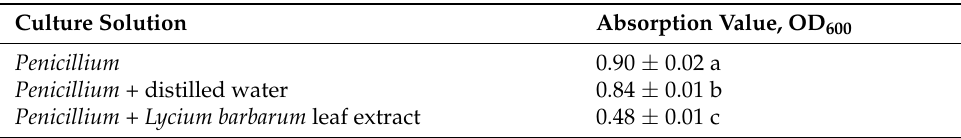
Figure 2. Inhibitory effects of different treatments on Penicillium . Note: ( A ) represents Penicillium growth as a control. ( B , C ) show the suppression of Penicillium by distilled water and Lycium barbarum leaf extract, respectively. Table 1. Antifungal activity of Lycium barbarum leaf Table 2. Changes in cherry tomato color under different treatments (20 °C).